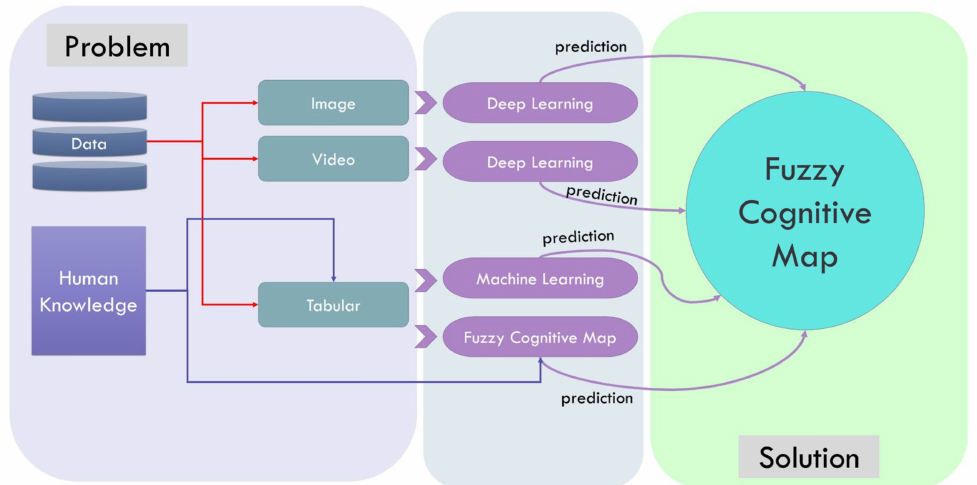
Figure 4. Ensemble ML-DL-FCM method for dealing with problems involving multiple data types and human